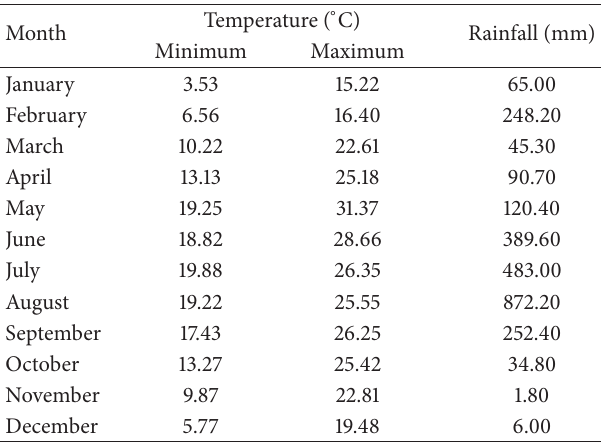
Table 1: Rainfall and temperature pattern in